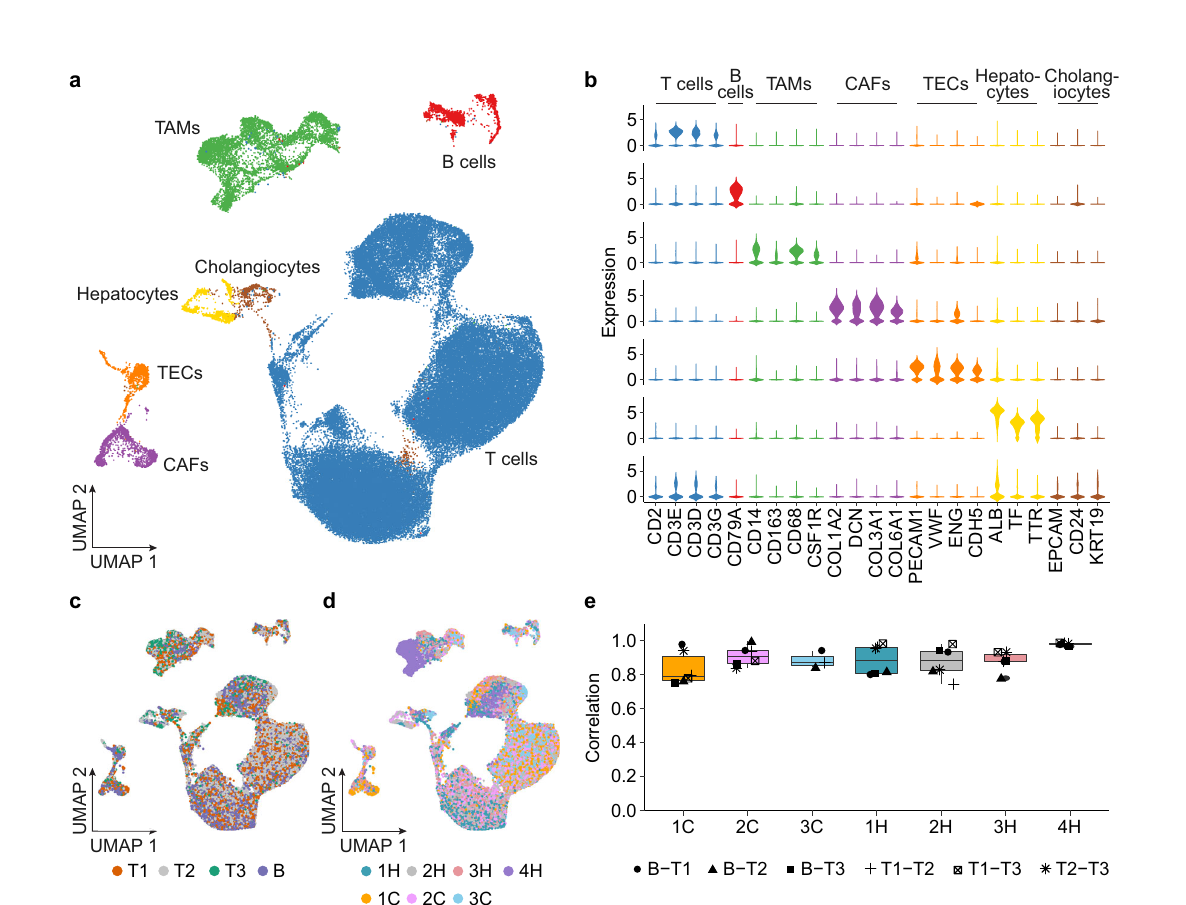
Fig. 3 | Landscape of multiregional non-malignant cells. a UMAP of non- malignant cells colored by cell types. CAFs, cancer-associated fi broblasts; TAMs. tumor-associated macrophages; TECs, tumor-associated endothelial cells. b Violin plotsofcell-typespeci fi cmarkergeneexpressioninnon-malignantcells. c , d UMAP of non-malignantcells colored by tumor regions ( c ) and case IDs ( d ). e Correlation